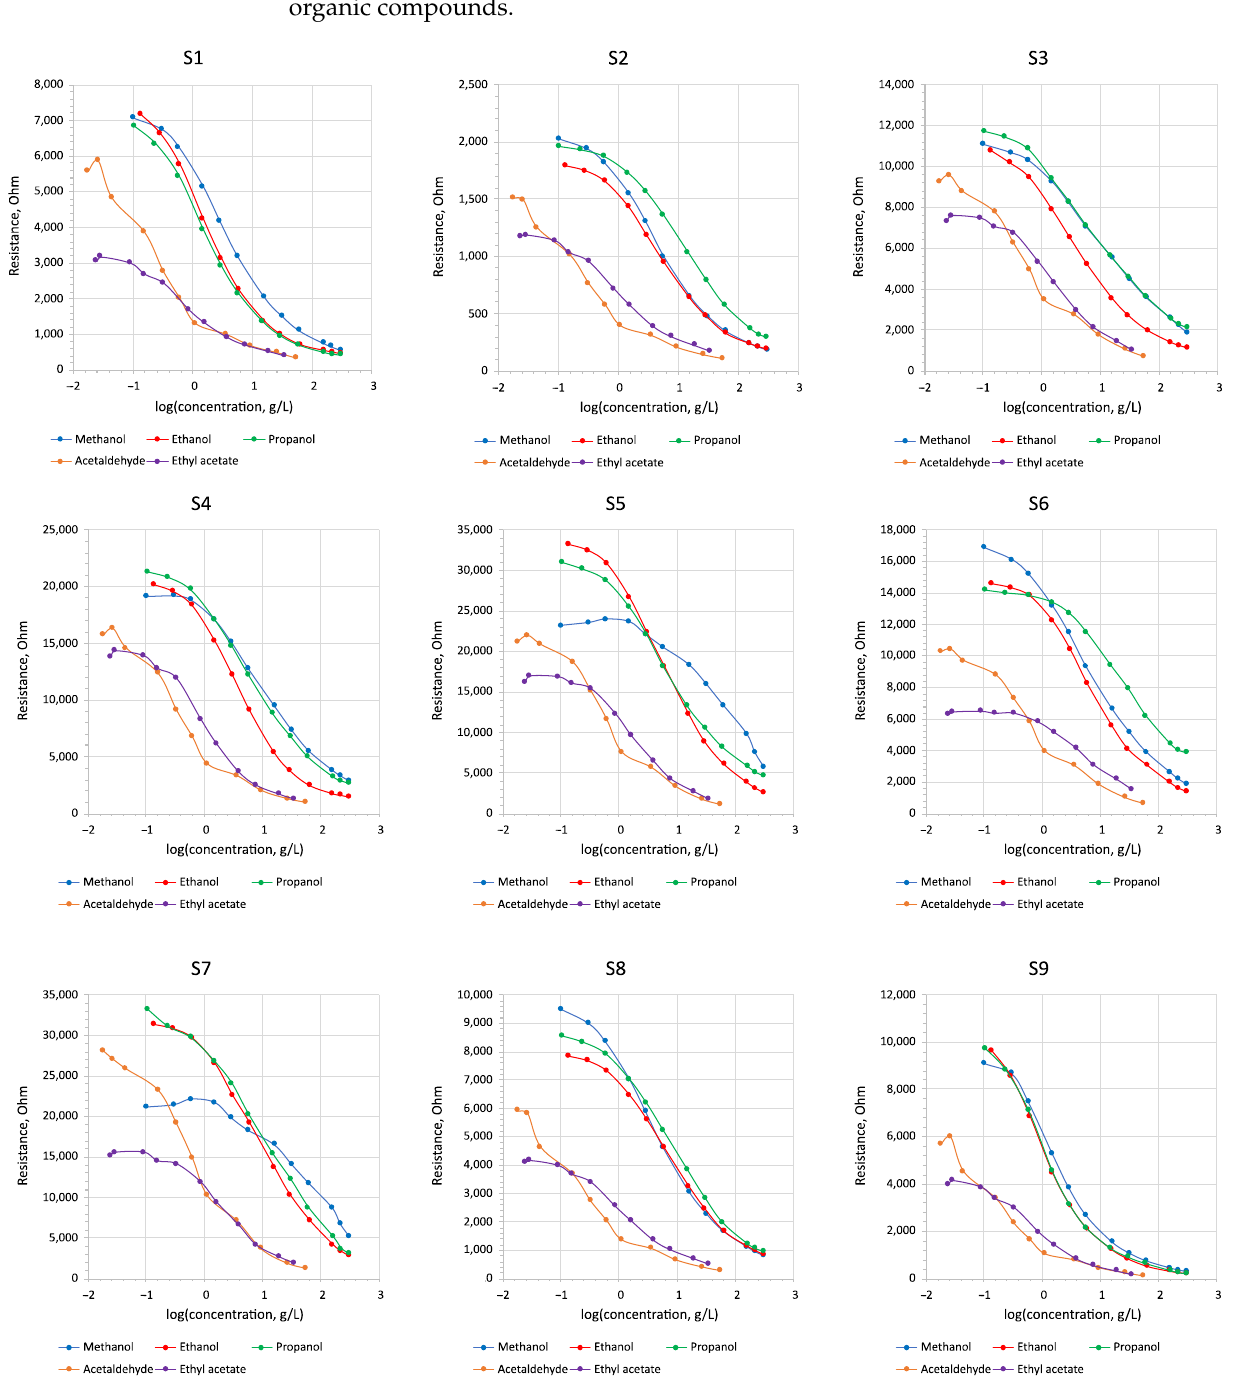
Figure 2. Sensors’ response curves using aqueous solution of an individual organic compound (logarithmic scale of concentrations, g/L). S1-S9 are MOS Figaro gas sensors (description in Table 2) used in the Enose sensor array.